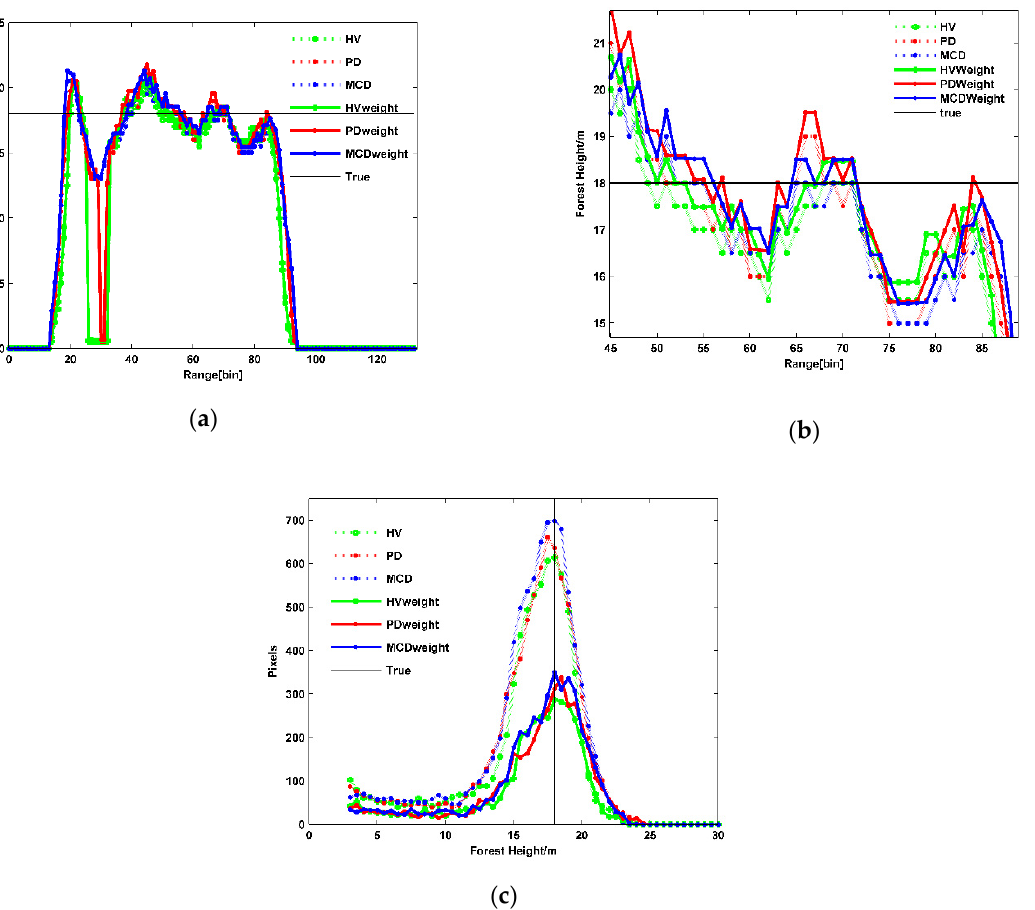
Figure 9. Profile and statistical histogram of the inversed forest height. ( a ) Profile of the inversed forest height; ( b ) Enlargement image of Figure ( a ) in the range at 45~90; ( c ) Statistical histogram of the inversed forest height. Table 3. Results of forest height inversion.